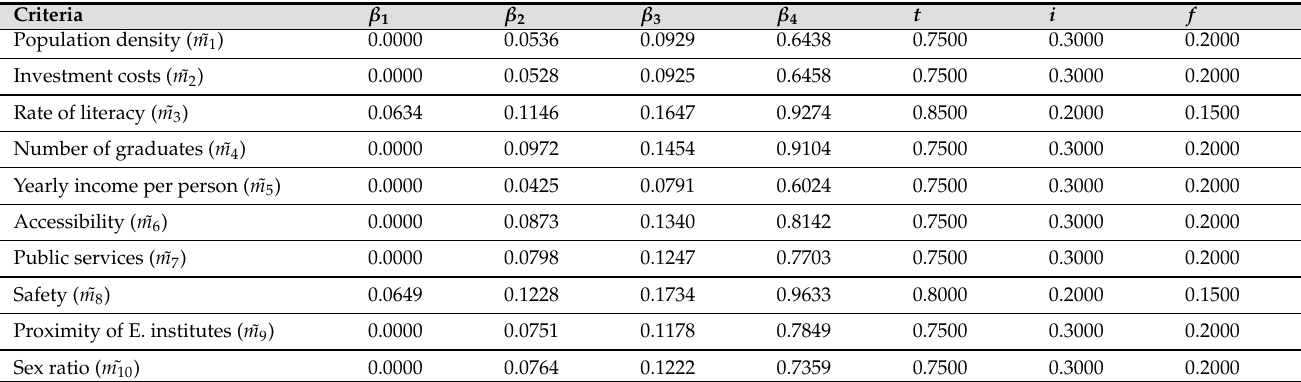
Table 17. Depiction of neutrosophic criteria weight for criterion’s.